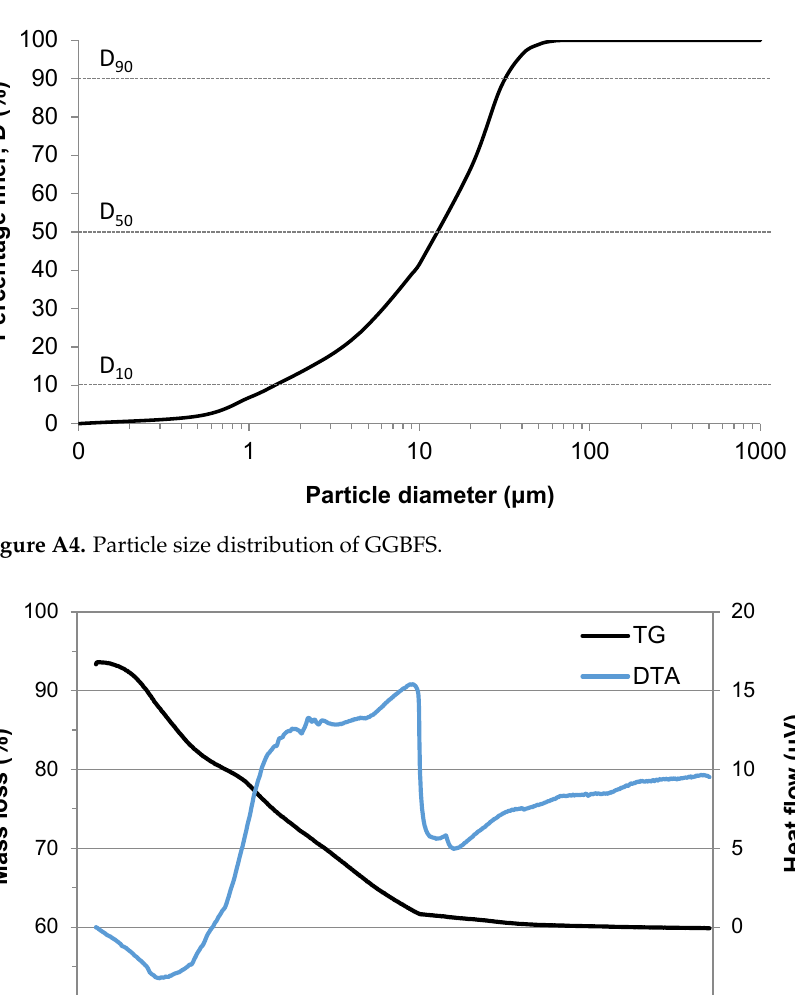
Figure A3. XRD pattern of GGBFS (m: merwinite PDF 35-0591, a: akermanite PDF 01-087-0046, b: brownmillerite PDF 01-074-3673 and q: quartz PDF 33-1161).